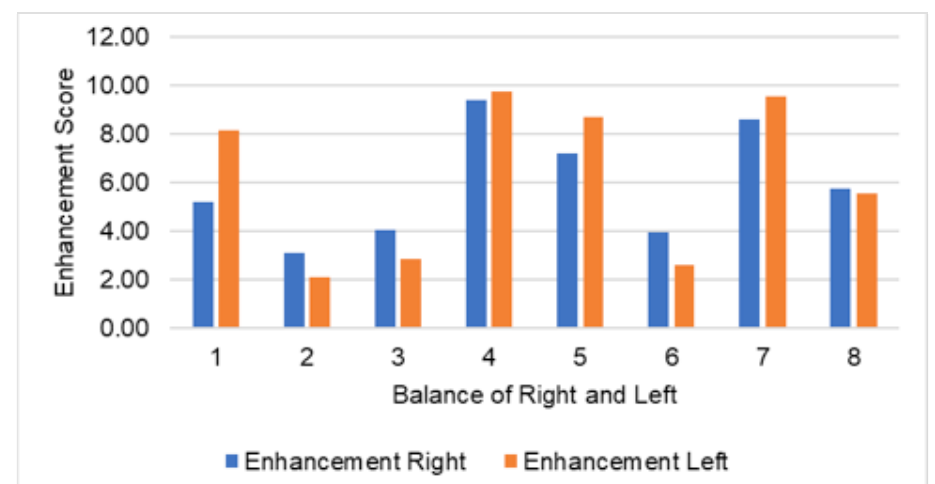
Figure 5. Data of balance bosu ball exercise 16 years old